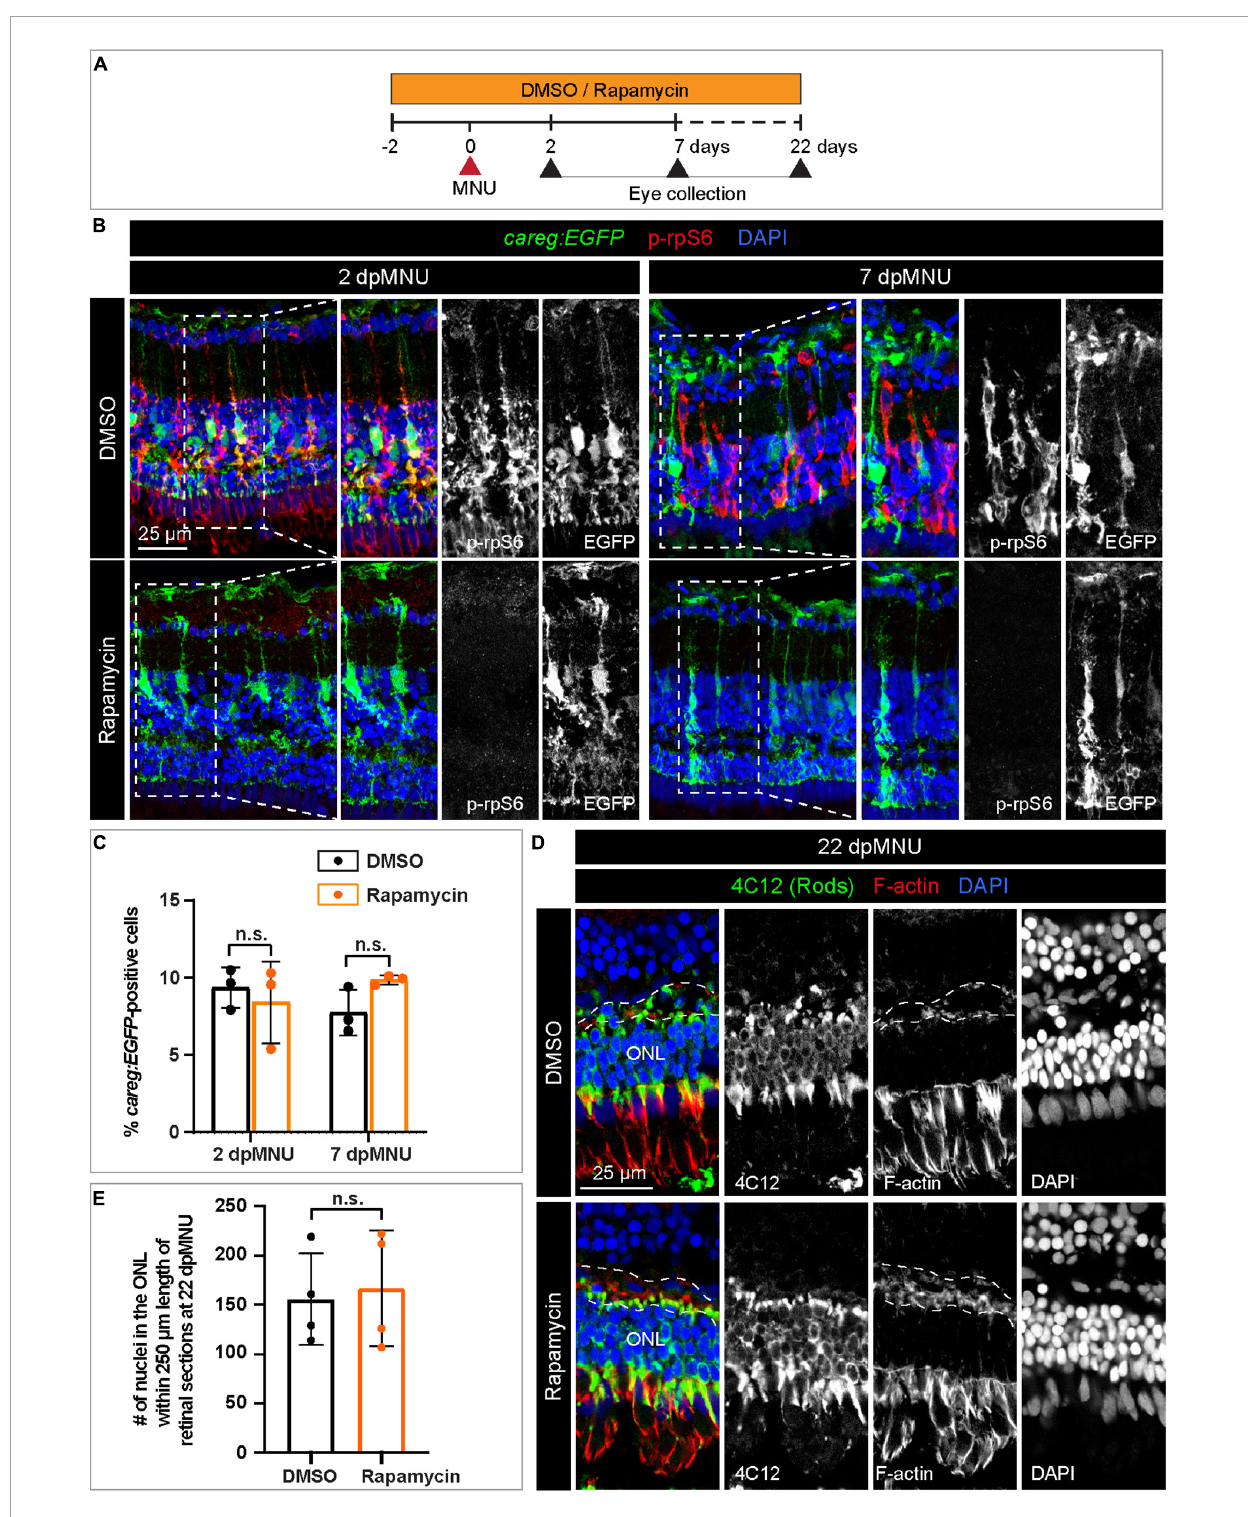
FIGURE10 The careg element is not regulated by TOR signaling in regenerating retina. (A) Experimental design with 0.1% DMSO and 1 µ M Rapamycin treatment. (B) Transversal sections of regenerating careg:EGFP (green) retinas at 2 and 7 dpMNU treated with DMSO or Rapamycin immunostained for the phosphorylated ribosomal protein p-rpS6 (red). Rapamycin treatment suppresses p-rpS6 immunoreactivity without affecting careg:EGFP expression (green). (C) Quantification of careg:EGFP -positive cells show a non-significant change between DMSO and Rapamycin-treated samples. Error bars, SEM. P -value was determined by two-way ANOVA with Sidák multiple comparisons test. n.s., not significant; N = 3. (D) Immunostaining of retina at 22 dpMNU demonstrates restoration of 4C12-positive rods (green) and F-actin-positive synaptic processes of the outer plexiform layer (encompassed with a dashed line). The position of outer nuclear layer (ONL) is indicated. (E) Quantification of nuclei in the outer nuclear layer within 250 µ m length of retinal sections at 22 dpMNU. Error bars, SEM. P -value was determined by unpaired two-tailed Student’s t -test. n.s., not significant; N =